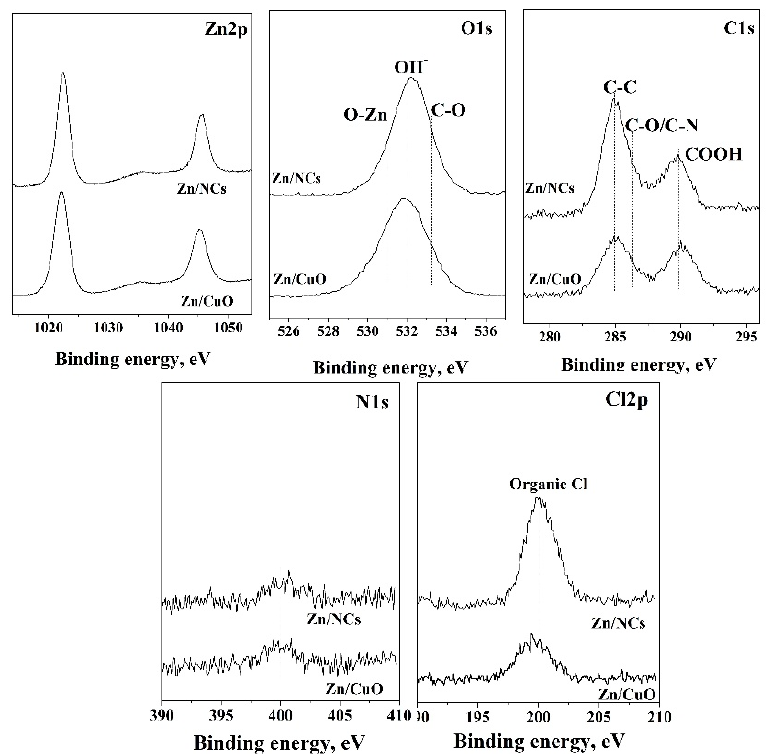
Table 4. Binding energy values of the registered elements in the investigated samples.